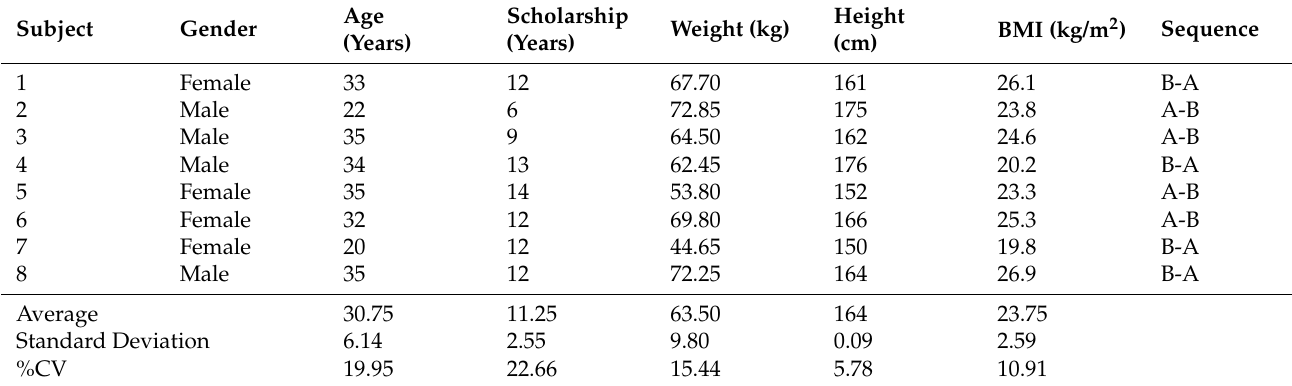
Table 2. Demographic data for MEP-administered